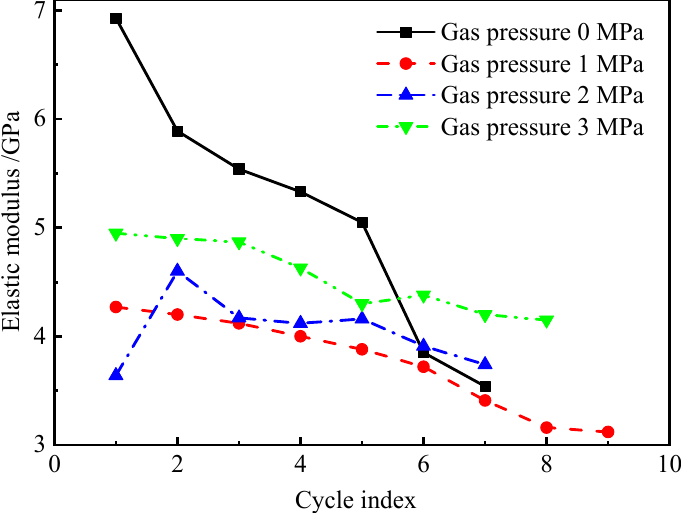
Figure 7. Evolution of elastic modulus under different gas pressure conditions.